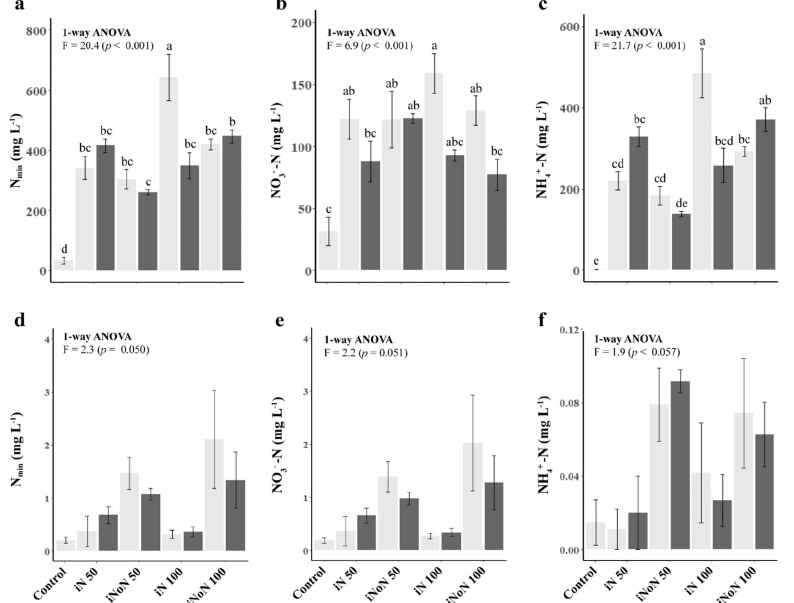
Figure 2. ( a , d ) Mineral N (N min = NO 3 − –N + NH 4+ –N, ( b , e ) nitrate (NO 3 − –N) and ( c , f ) ammonium (NH 4+ –N) concentrations in macadamia leachates after ( a – c ) 3 weeks and ( d – f ) 11 weeks growing under different fertilizer N sources (iN, iNoN) without or with PGPR inoculation. Light grey bars represent uninoculated treatments; dark grey bars display treatments inoculated with PGPR. Shown are mean mineral N concentrations in soil-leachate (±SE, n = 4). Different letters above means indicate significant differences among treatments (one-way ANOVA and Tukey’s post hoc tests, p < 0.05).